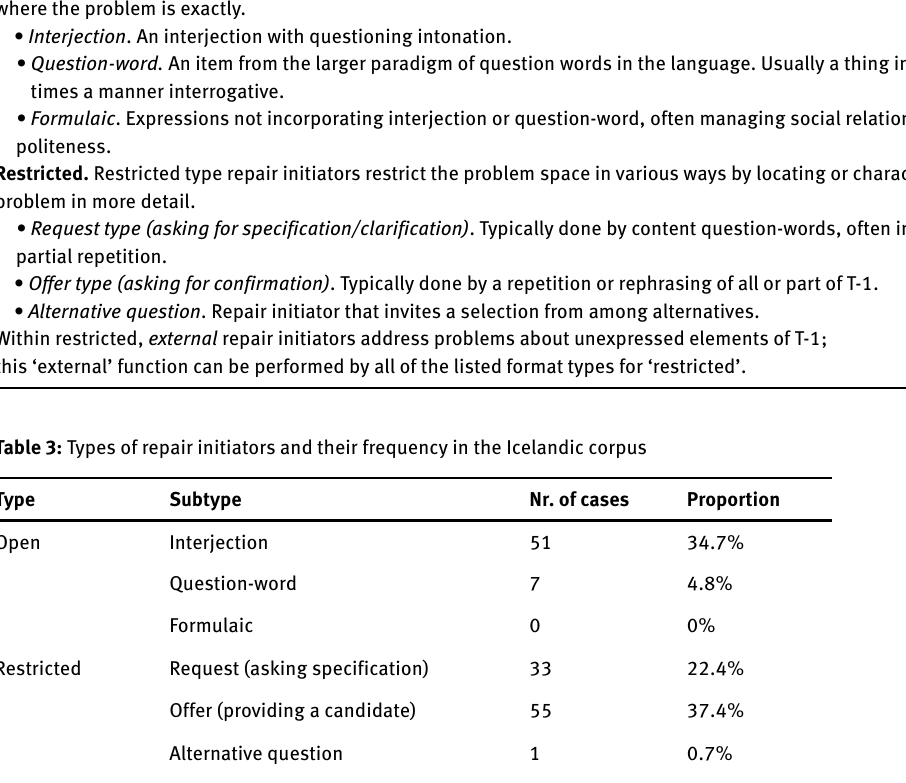
Open. Open type repair initiators are requests that indicate some problem with the prior talk while leaving open what or where the problem is exactly.